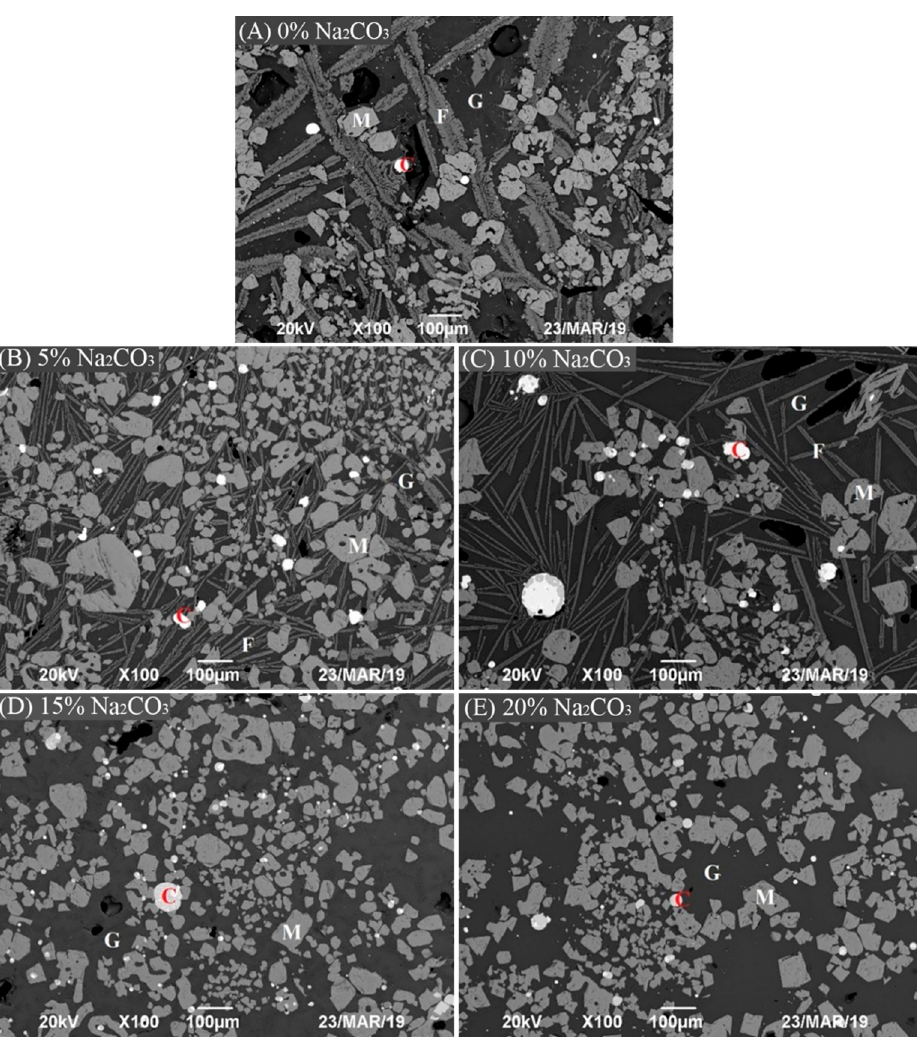
Figure 10. XRD spectra of Cu slag with different amounts of Na 2 CO 3 (CPS — Count per second) .